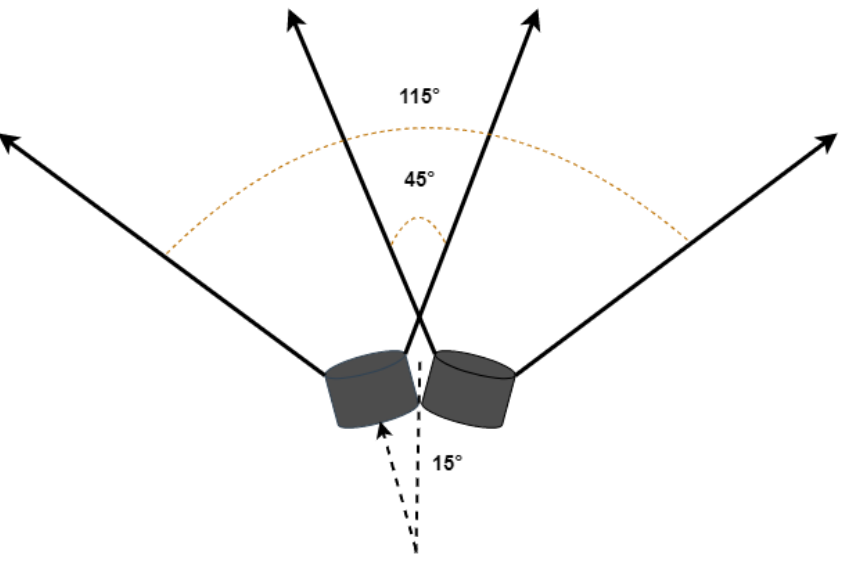
Figure 6. Ultrasonic sensors’